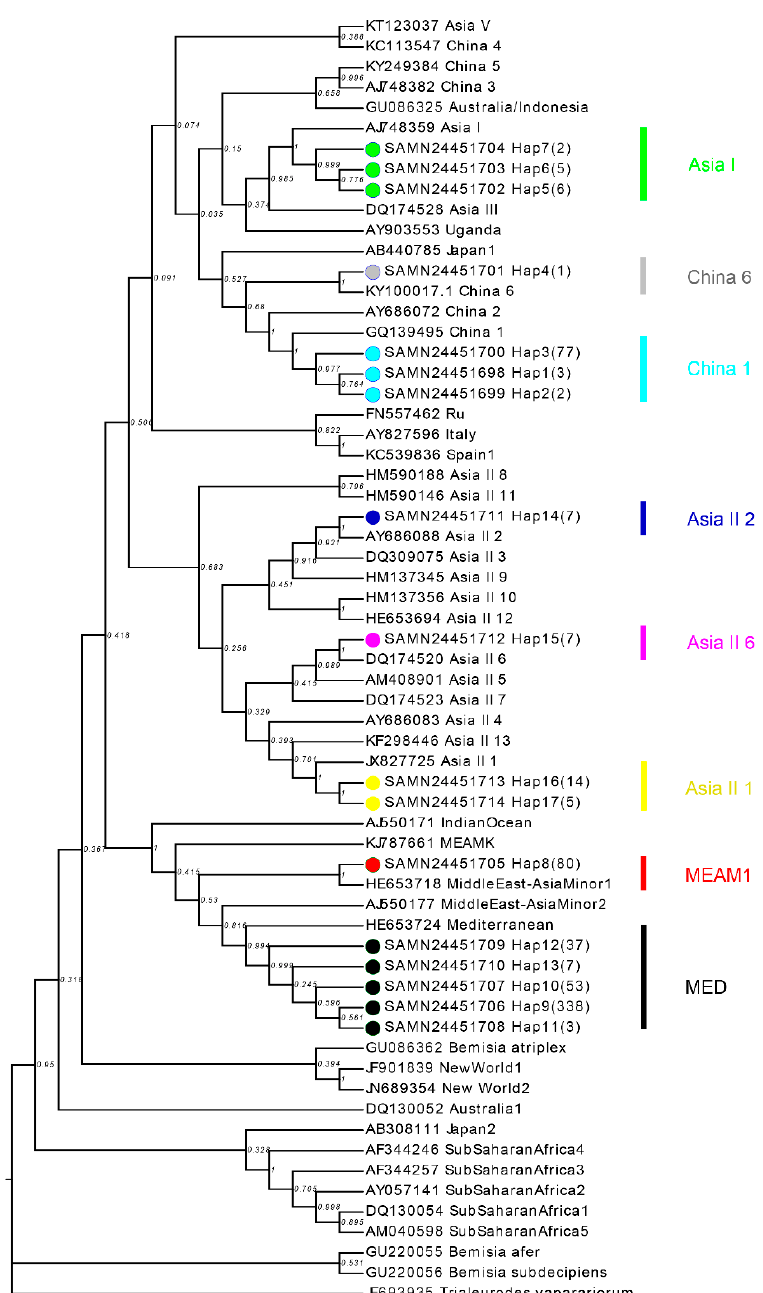
Figure 1. Phylogenetic tree analysis of Bemisia tabaci cryptic species inferred from mt COI sequences using neighborhood-joining method. The similar topological tree was generated using maximum likelihood method. The circles represent the sequences obtained from the current study and the other known sequences are retrieved from GenBank following the previous report by Kanakala and Ghanim, 2019. Different circle colors indicate different cryptic species of Bemisia tabaci .